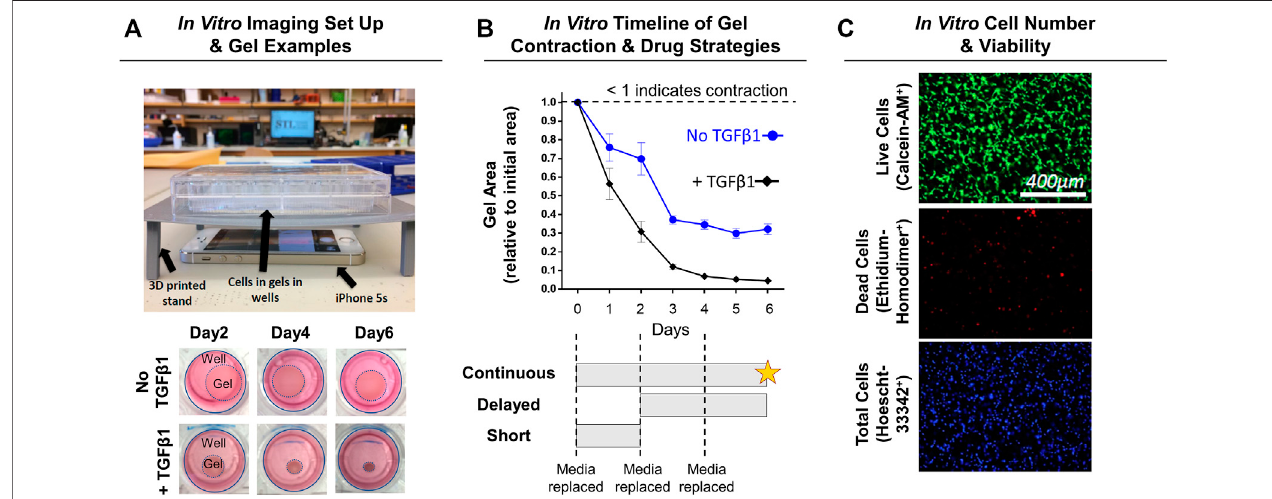
FIGURE 2 | Experimental design for in vitro NIH3T3 fi broblast-embedded gel contraction. (A) Imaging set-up used to monitor gel contraction. Representative imagesofcollagengel(1.5 mg/ml)contractionbyembeddedNIH3T3 fi broblasts(5 × 10 5 cells/ml)withandwithoutTGF β 1(10 ng/ml)overtime.Note:Day0isnotshown as the gels are approximately the same size as the well, and intermediate timepoints are sizes in between the days shown. (B) Quanti fi cation of gel contraction and drug dosingstrategiesused.Resultsareshownasaverage ± SEM( n (cid:1) 12forNoTGF β 1; n (cid:1) 19for+TGF β 1).Note:star (cid:1) live/deadassay. (C) Representativeimagesof live, dead, and total cell staining used to quantify cell number (# of nuclei) and viability (% viable).